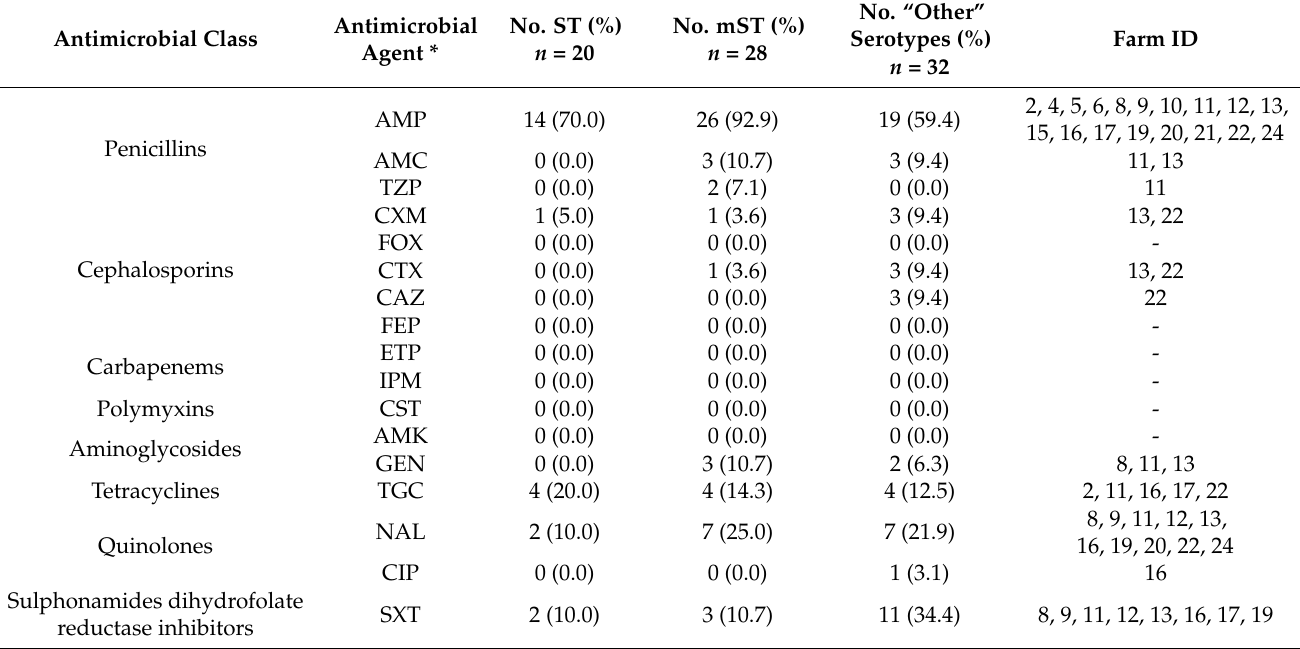
ST: Salmonella Typhimurium; mST: monophasic variant of S . Typhimurium. * Ampicillin (AMP), amoxicillin- clavulanic acid (AMC), piperacillin-tazobactam (TZP), cefuroxime (CXM), cefoxitin (FOX), cefotaxime